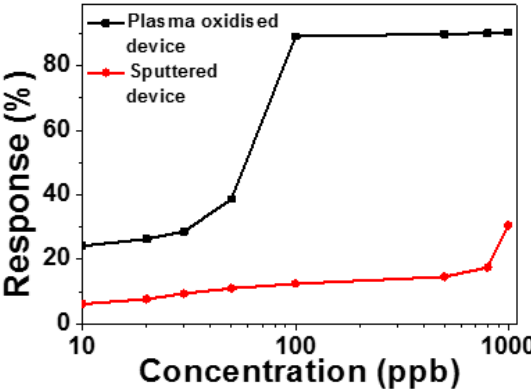
Figure 3. Sensitivity comparison of plasma oxidized and sputtered